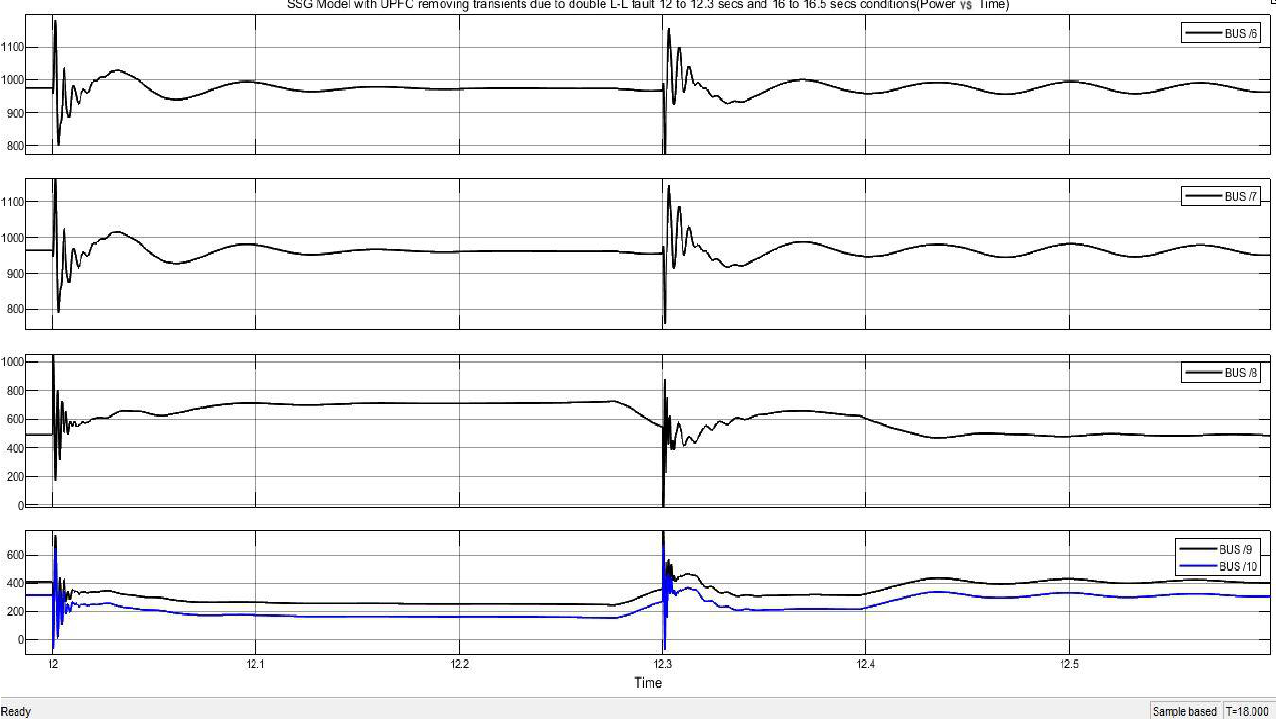
Figure 37. Transient stability being provided by UPFC after multiple L-L-L faults are introduced at 12 to 12.3 s (Bus 6 to Bus 10).